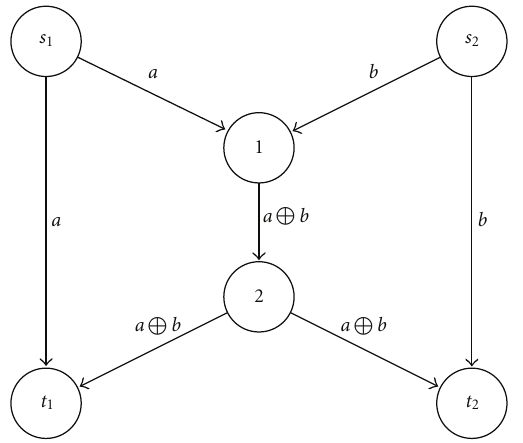
Figure 2: The single-source two-sinks multicast butterfly network.